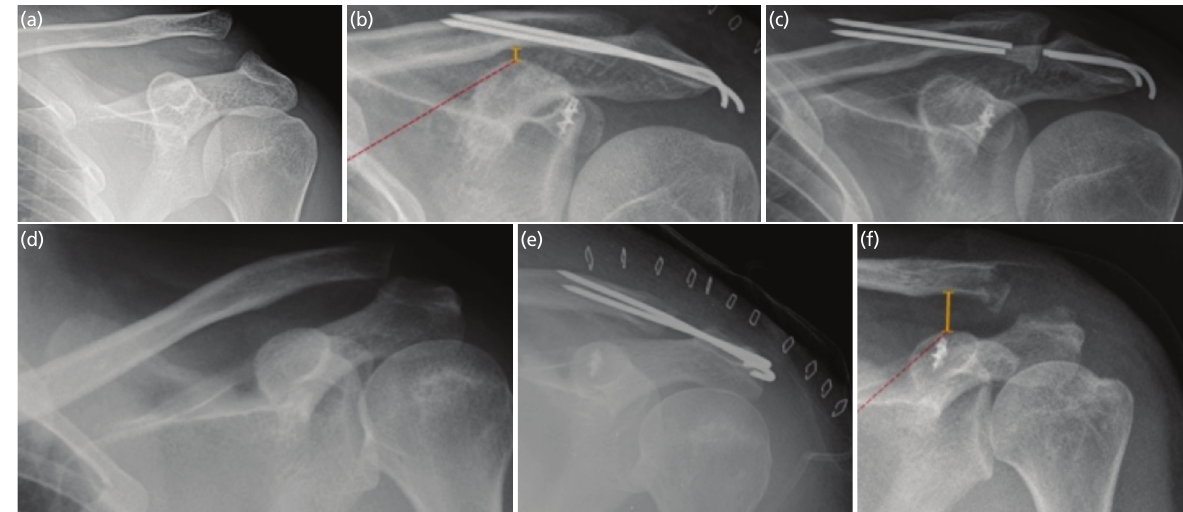
Fig. 4: Anteroposterior radiographs of acromioclavicular joints showing post-operative complications – K wire breakage; (a) pre-op, (b) immediate post-op, (c) follow-up. Loss of reduction following K wire removal (d) pre-op, (e) immediate post-op, (f)